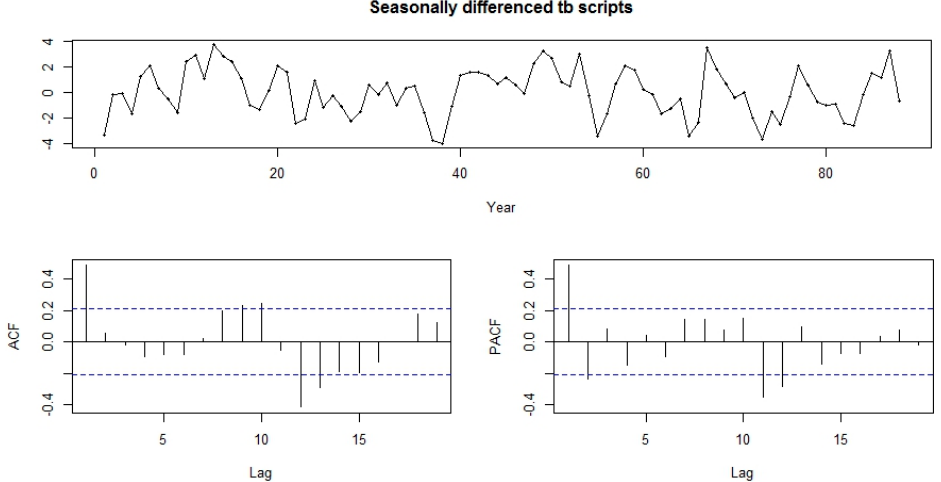
Figure 5. Time plot, ACF and PACF plot for differenced seasonality adjusted monthly TB cases prevalence.